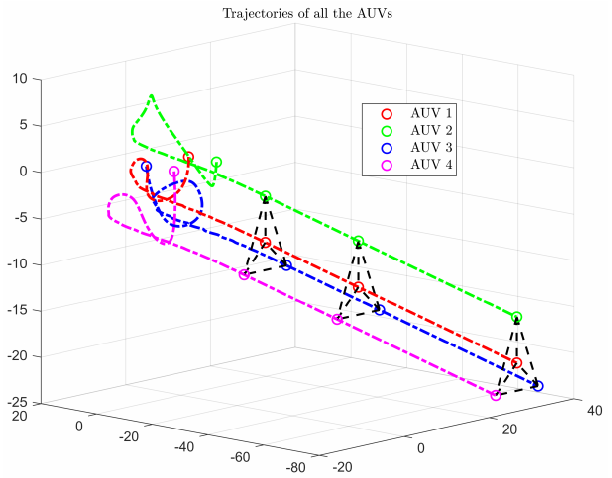
Figure 7. Three dimensional trajectories of all of the AUVs.